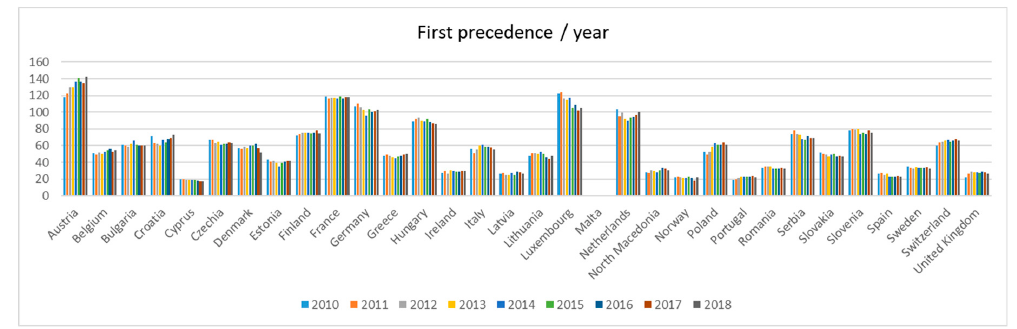
Figure 7. Number of the long precedencies by country, 2010–2018—geospatial distribution.